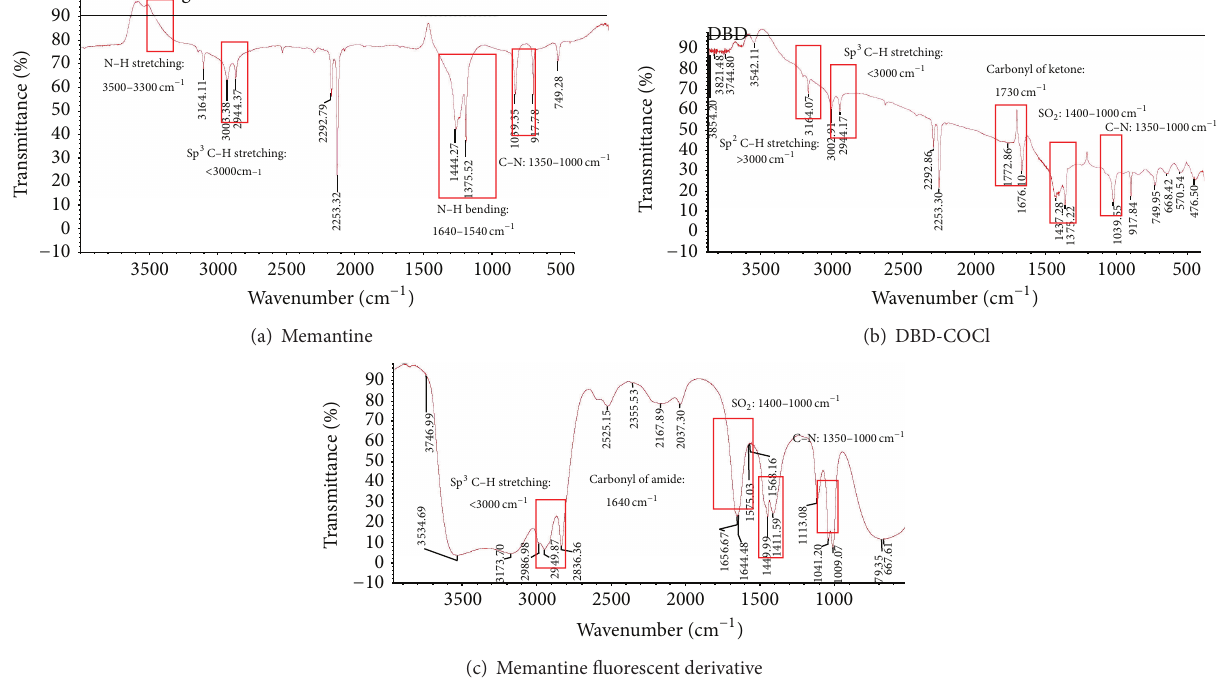
Figure 5: Infrared spectra of (a) memantine, (b) DBD-COCl, and (c) memantine fluorescent derivative.